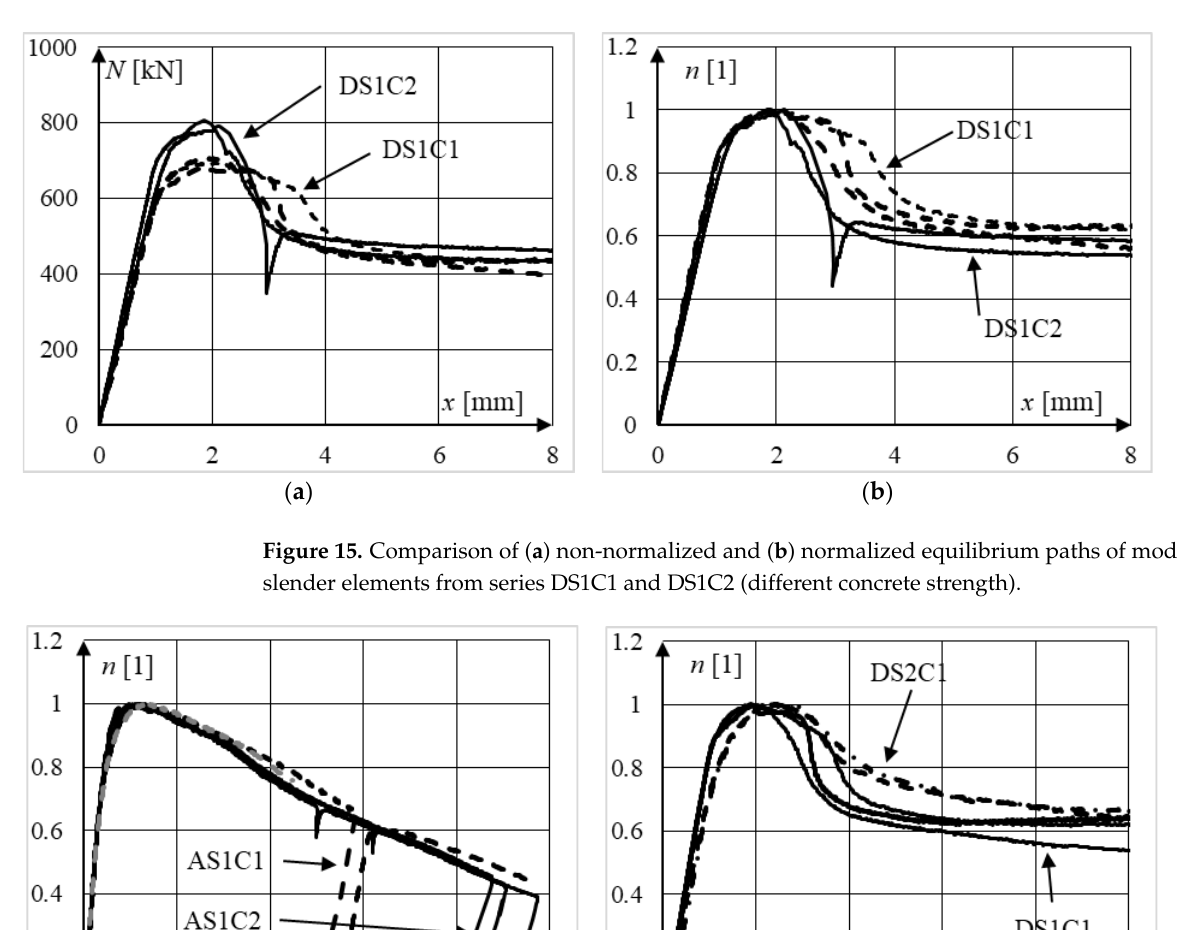
( b ) Figure 14. Comparison of normalized equilibrium paths of: ( a ) steel columns from all series; ( b ) slender composite columns from series AS1C1 and BS1C1. The influence of the concrete strength on the ductility of moderately slender compo- site columns can be seen in Figure 15a, where both standard and normalized equilibrium paths of elements from series DS1C1 and DS1C2 are presented. On analyzing the pre- sented data, it can be concluded that the use of stronger concrete increases the ultimate